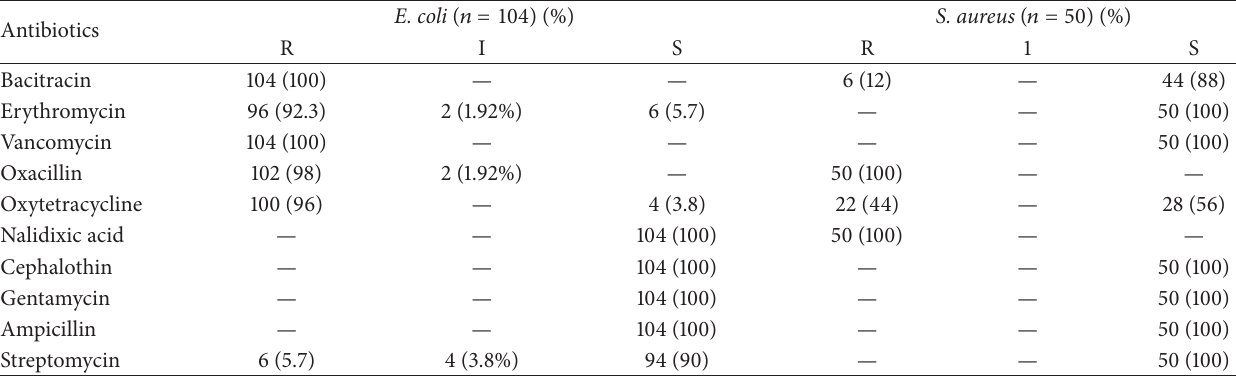
Table 5: Antimicrobial susceptibility profile of S. aureus and E. coli isolated from cattle and pigs